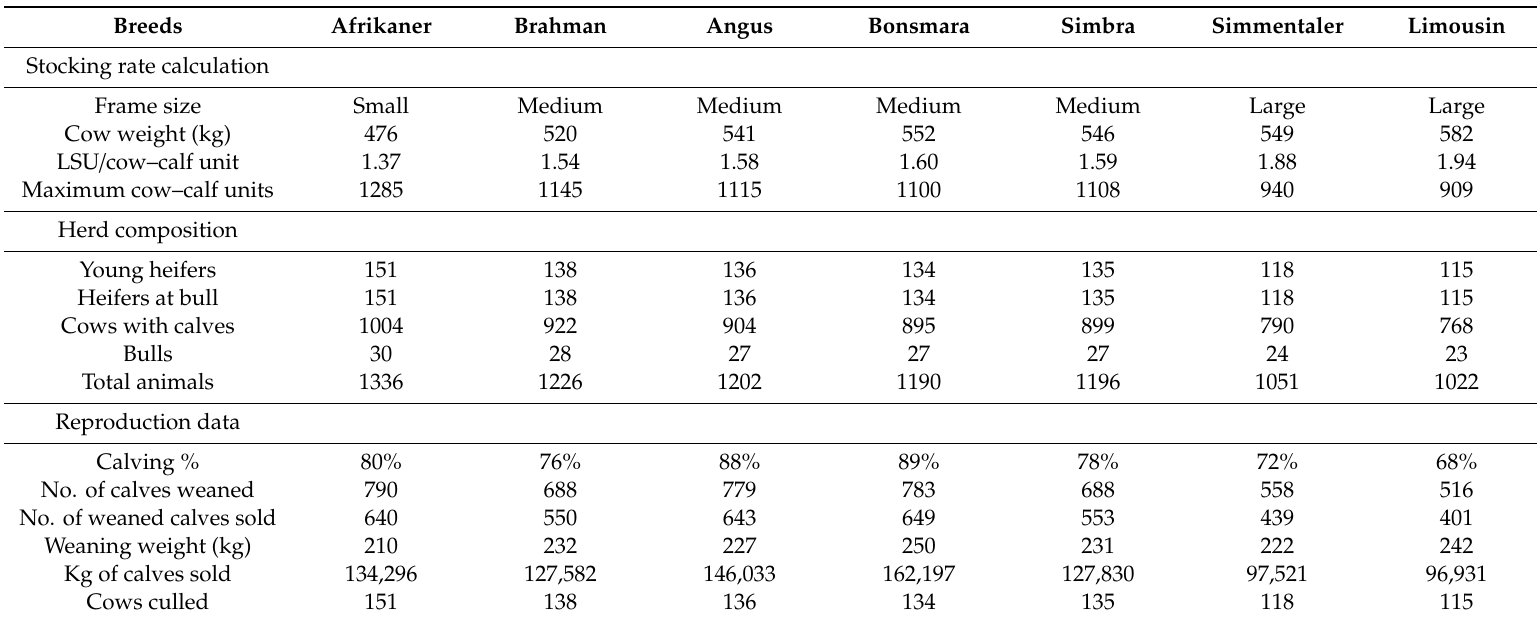
Table 3. Simulated herd composition of the di ff erent cattle